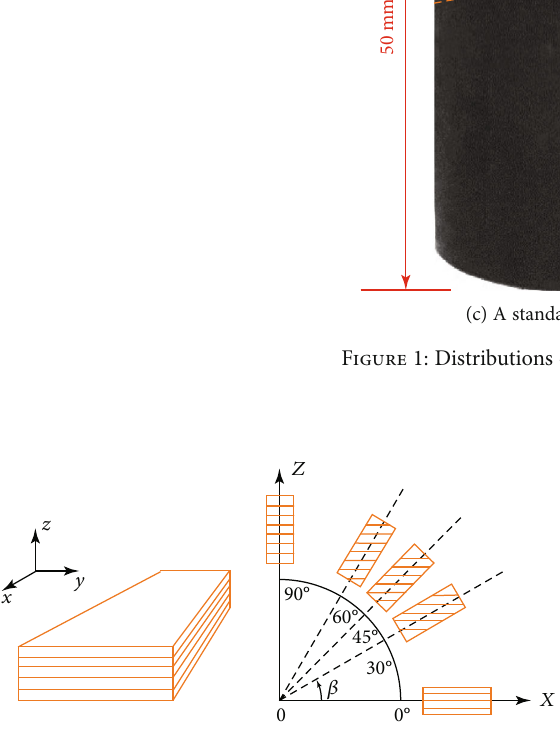
Figure 2: Illustration of coring directions of shale